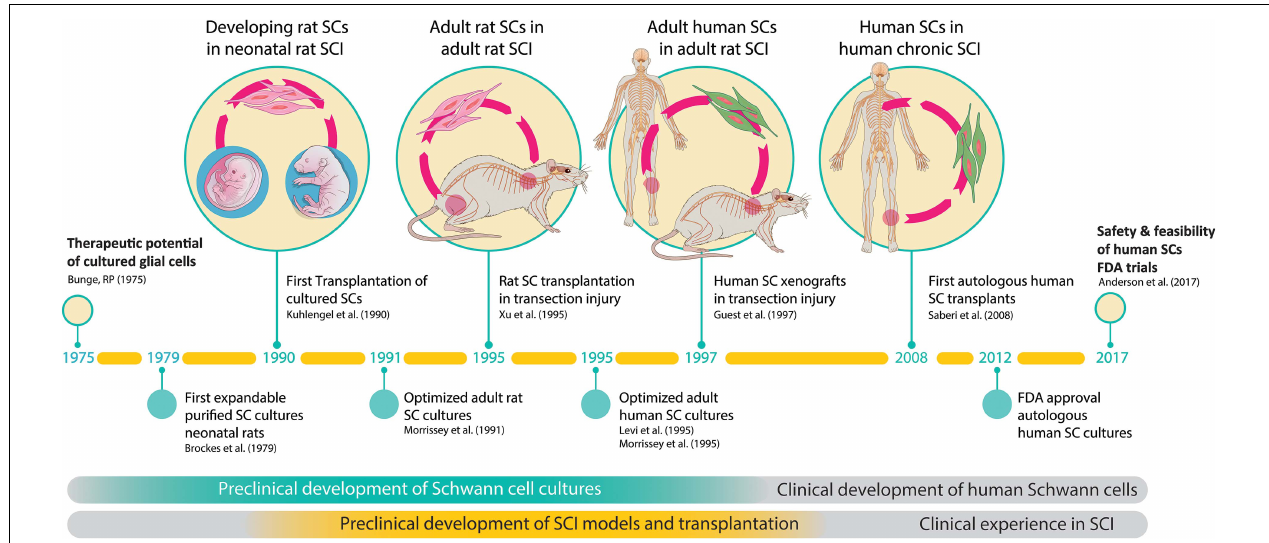
FIGURE 2 | The path to clinical translation of SC transplantation in SCI. The timeline summarizes milestones and selected major achievements in support of the overall strategy. The history of work explaining progress made since the conception of the original idea (Bunge, 1975) to the completion of the first FDA-sanctioned trial is described in the text. Much work was done in the initial phases to (i) develop technologies for SC culturing, and (ii) obtain proof-of-concept data of SC transplants in animal models of SCI. Notice the 20-year gap between the first reported animal study (Kuhlengel et al., 1990b) and the first clinical study (Saberi et al., 2008). FDA approval for the first safety trial in the USA was gained in 2012 (Xu, 2012) and the results released in 2017 (Anderson et al., 2017).